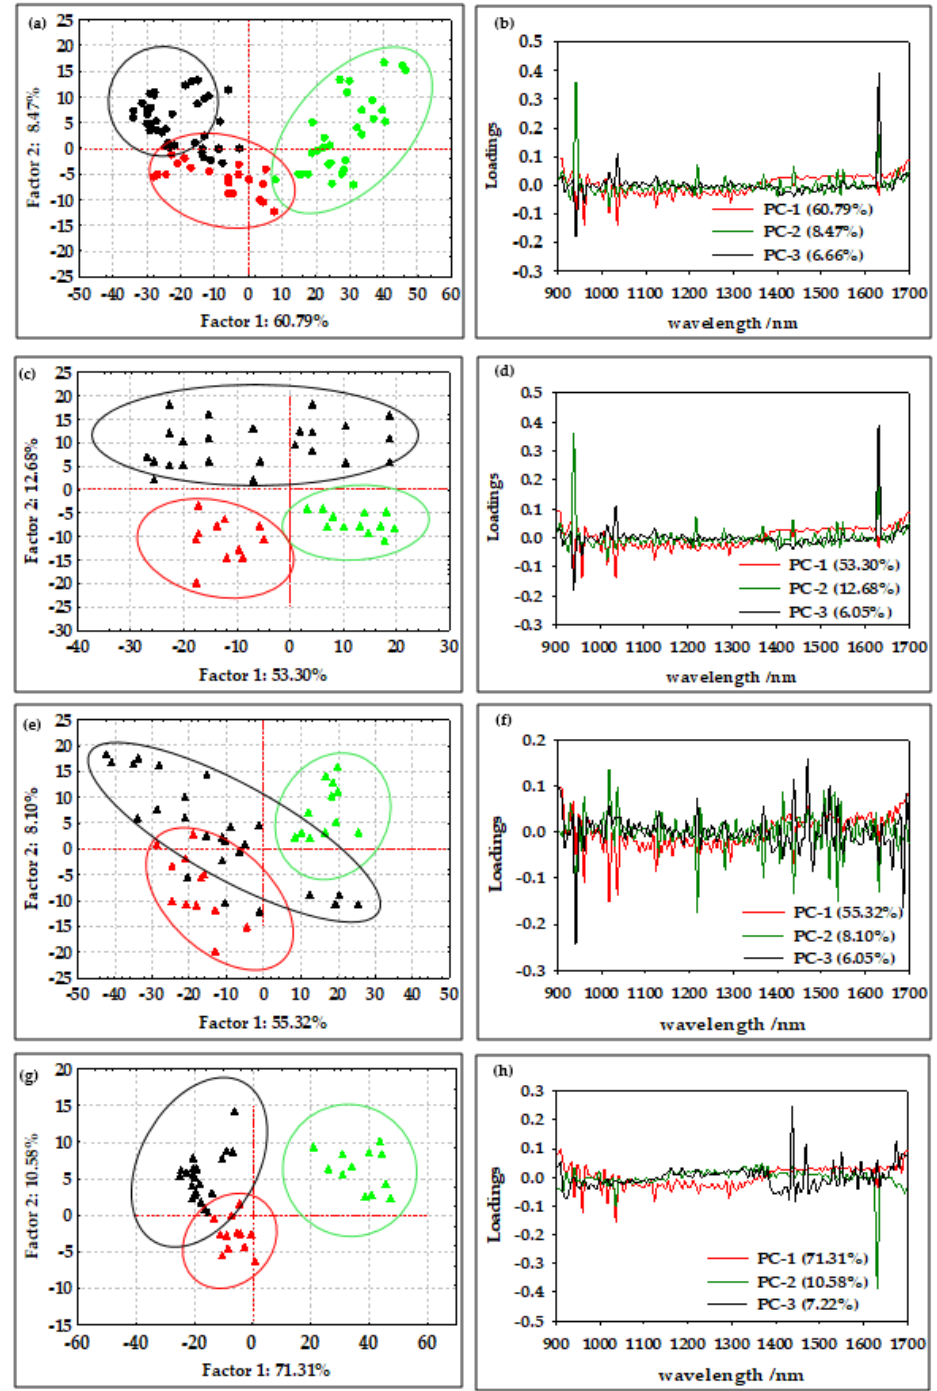
Figure 4. ( a ) PCA score plot of all average oil-in-water emulsion NIR spectra after SNV prepro- cessing ( • PEG 1500, • PEG 6000, • PEG 20,000). ( b ) PCA loading of all average oil-in-water emulsion NIR spectra after SNV preprocessing. PCA score plot of NIR spectra of oil-in-water emulsion NIR spectra after SNV preprocessing with ( c ) PEG 1500, ( e ) PEG 6000, and ( g ) PEG 20,000 ( 2% emul- sifier, 4% emulsifier, 6% emulsifier). PCA loading of NIR spectra of oil-in water emulsion NIR spectra after SNV preprocessing with ( d ) PEG 1500, ( f ) PEG 6000, and ( h ) PEG 20,000.